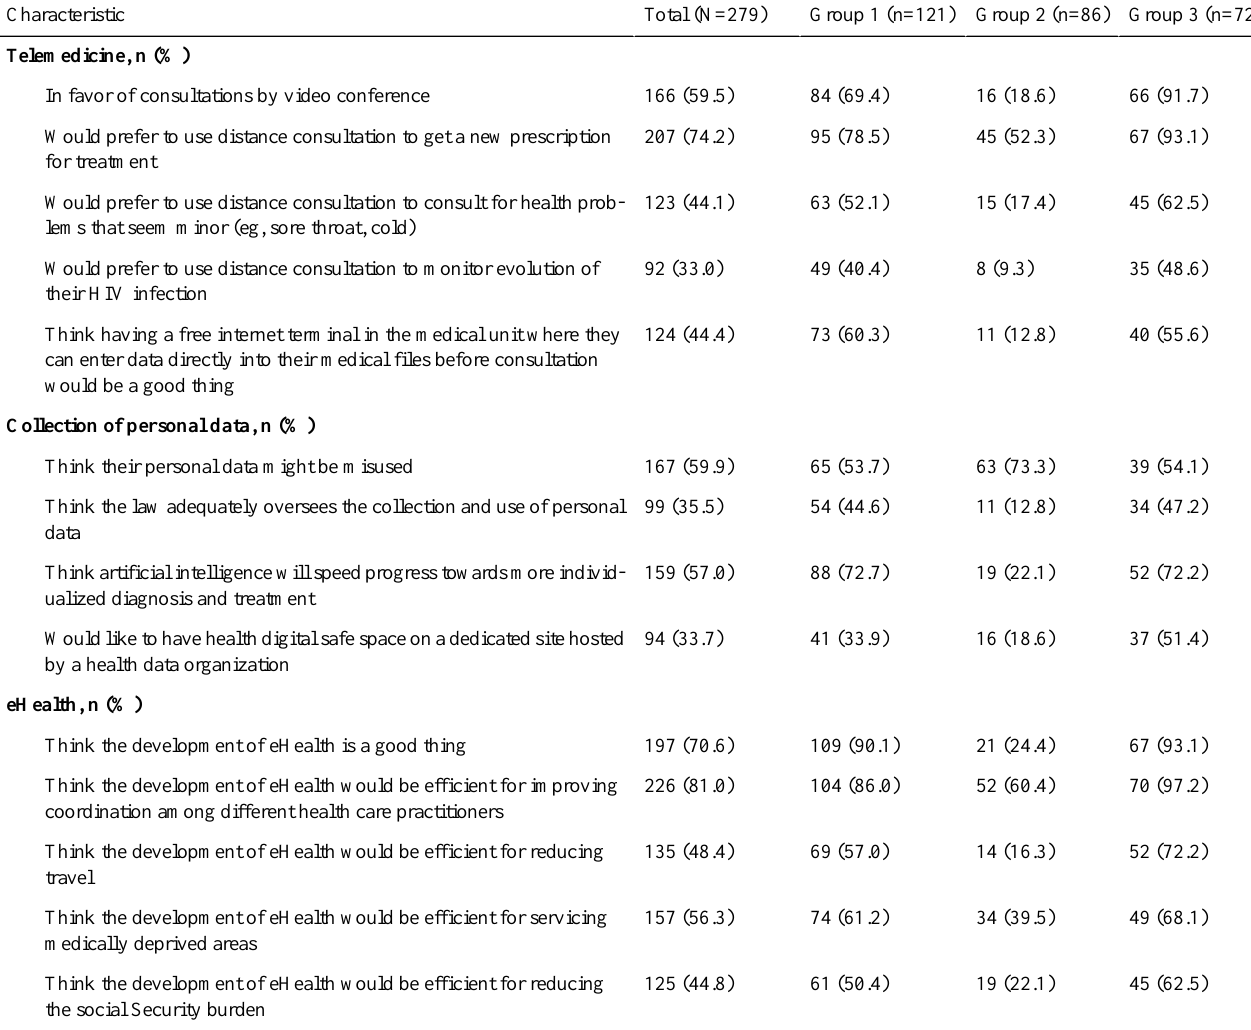
Table 5. Comparison of the three groups of people living with HIV obtained by mixed unsupervised